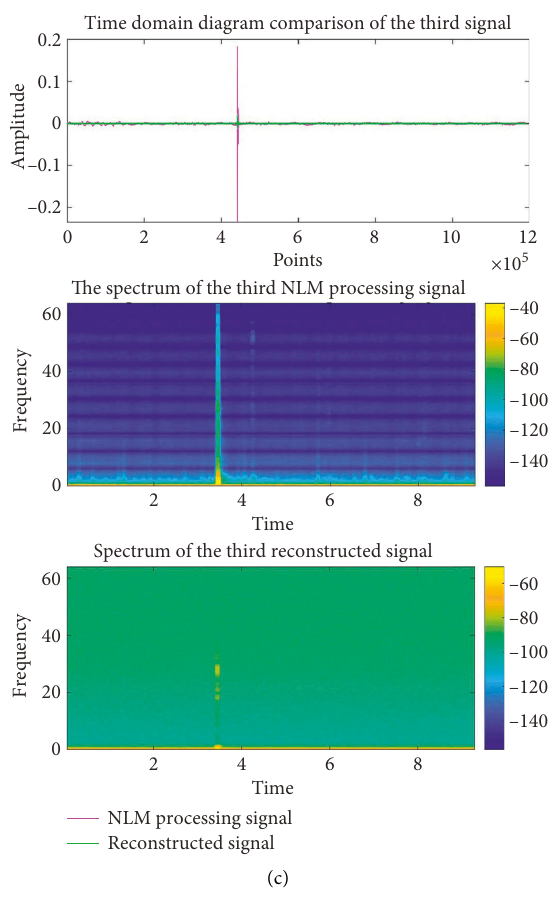
Figure 24: Comparison of three-way NLM processing signal and reconstructed signal. (a) Comparison of the first NLM processing signal and the reconstructed signal. (b) Comparison of the second NLM processing signal and the reconstructed signal. (c) Comparison of the third NLM processing signal and the reconstructed signal.